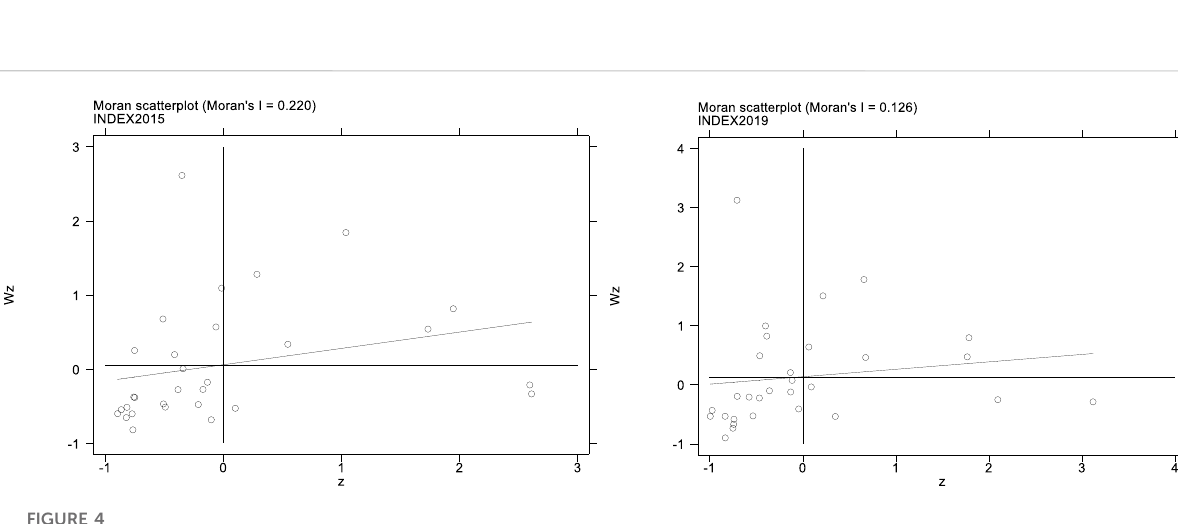
FIGURE 4 Moran ’ s I scatter plots of index in 2015 and 2019 for the 30 provinces.